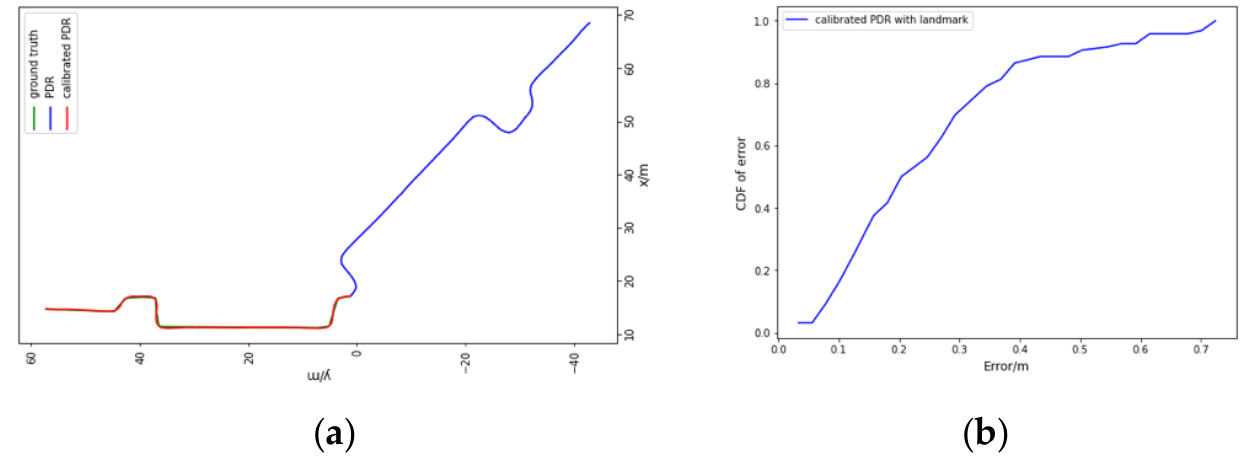
Figure 7. The performance ( a ) and the accumulative error distribution ( b ) of the proposed landmark-calibrated PDR.